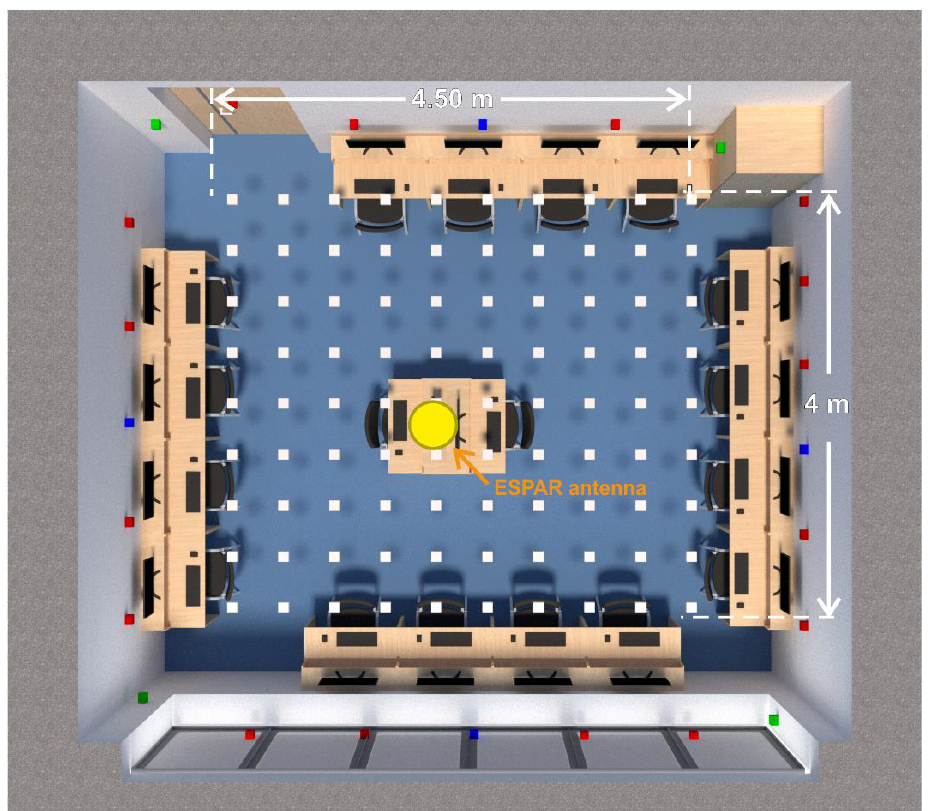
Figure 9. A 3D plan of the test environment, with the test positions marked as white squares and the reference nodes as blue, green, and red squares (see explanations in text).